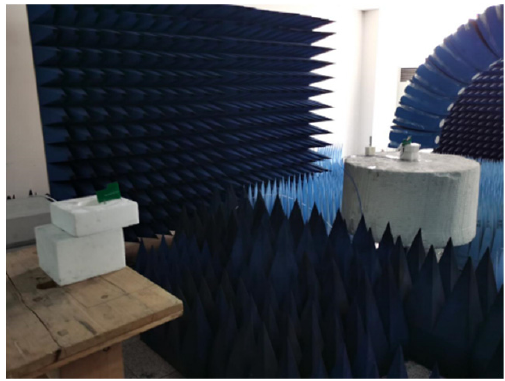
Figure 7. Schematic diagram of the position of the interfering object.